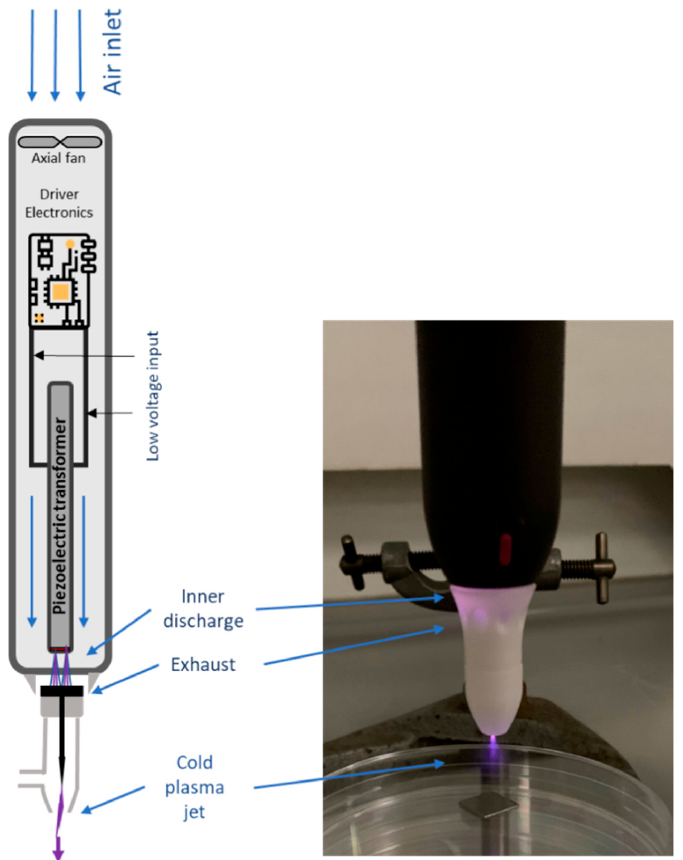
Figure 1. Schematic view of the handheld CAP system Piezobrush ® PZ2 with the multigas nozzle attached. Adapted from Timmermann et al. [22].